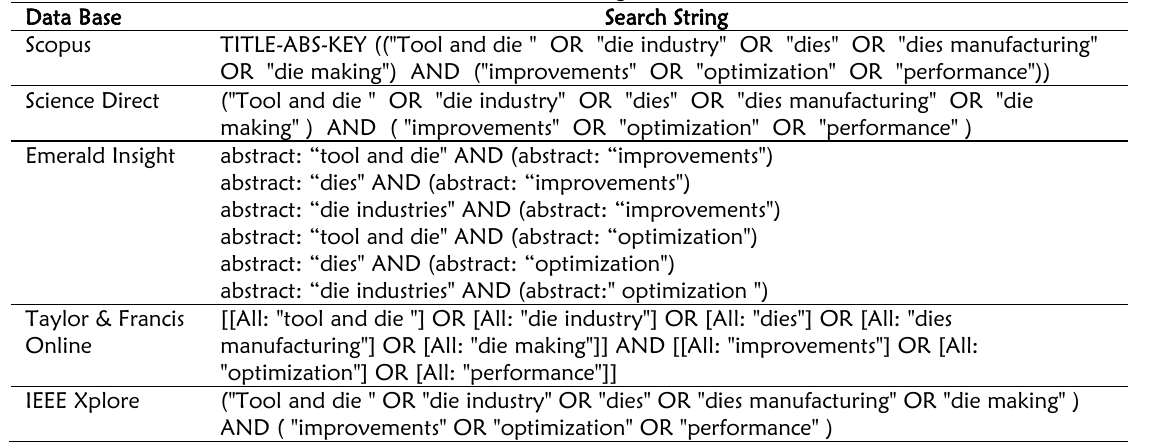
Table 2: The search string and database